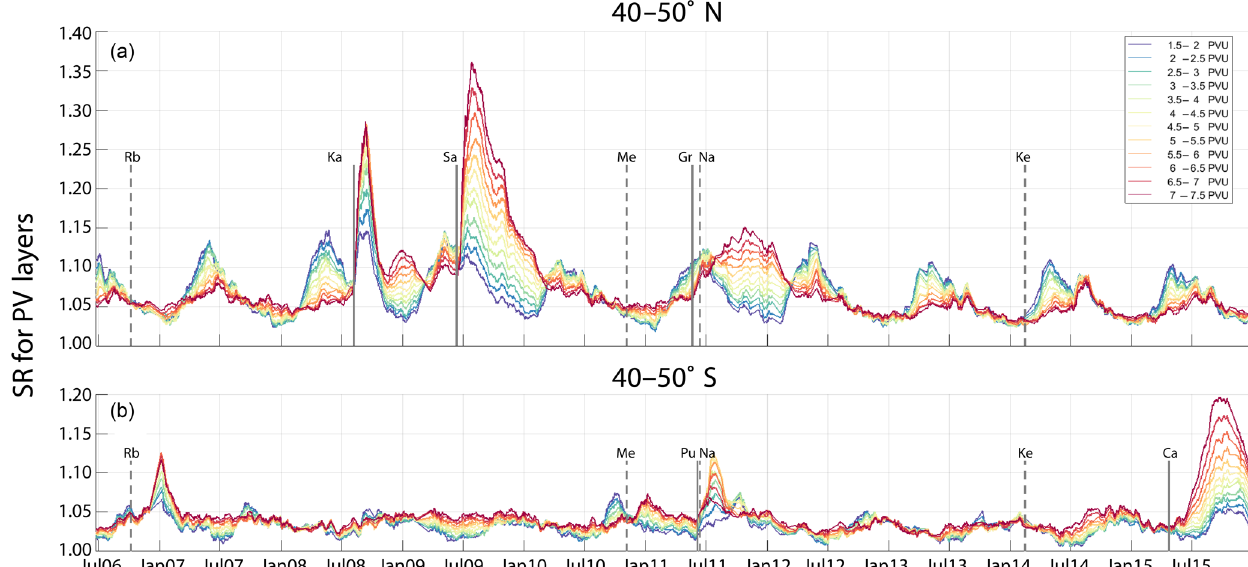
Figure 6. Temporal trends of the scattering ratio in altitude layers in the lower part of the LMS (PV intervals of 0.5PVU), for the latitude bands 40–50 ◦ N (a) and 40–50 ◦ S (b) . Vertical solid lines mark extratropical volcanic eruptions, and dashed lines indicate tropical eruptions that impacted the respective